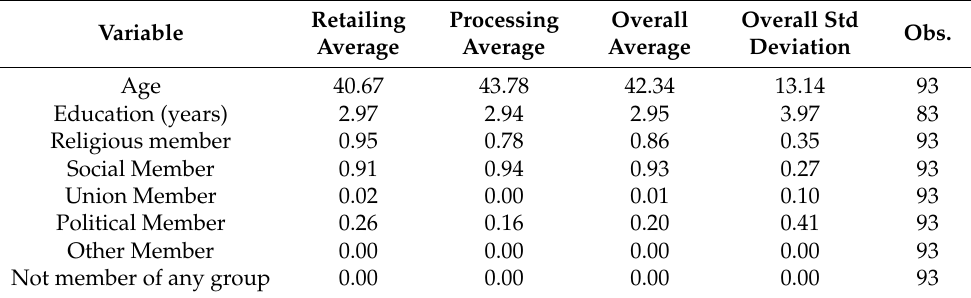
Table 1. Processors and Retailers Descriptive Statistics.